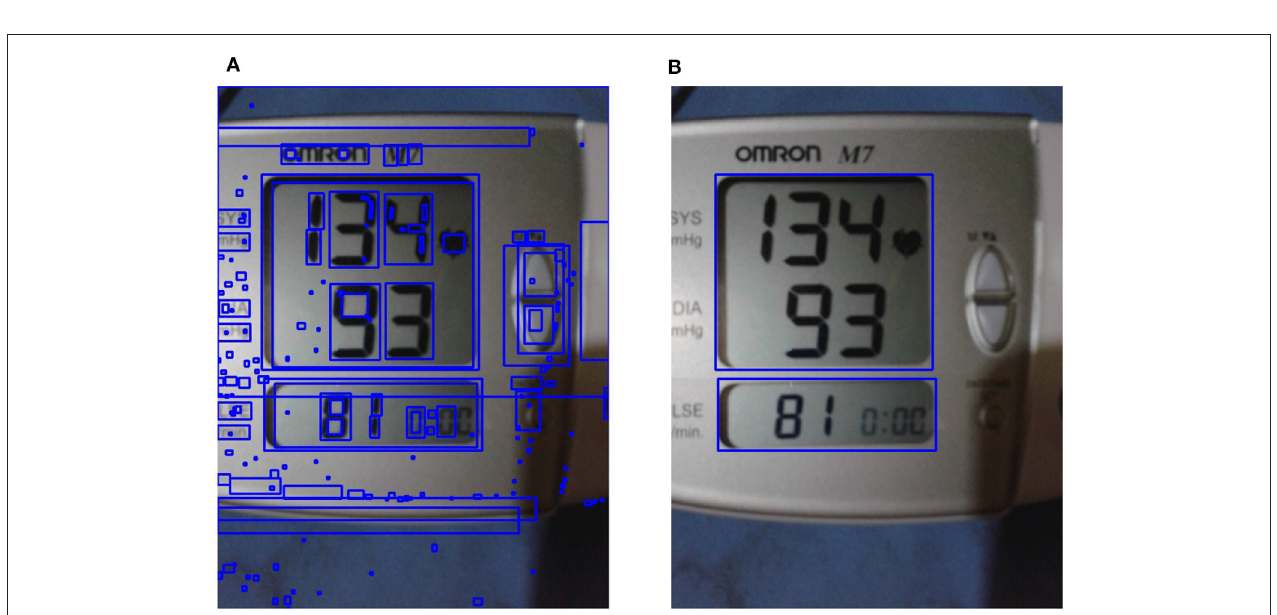
analysis on nearly 500 random images from the dataset, as validated by the work presented by Shah et al. (2009). Each of the BP LCD frames was further divided into half along vertical height to get systolic BP and diastolic BP LCD images. This sequence of single LCD binary images were fed to the number transcription